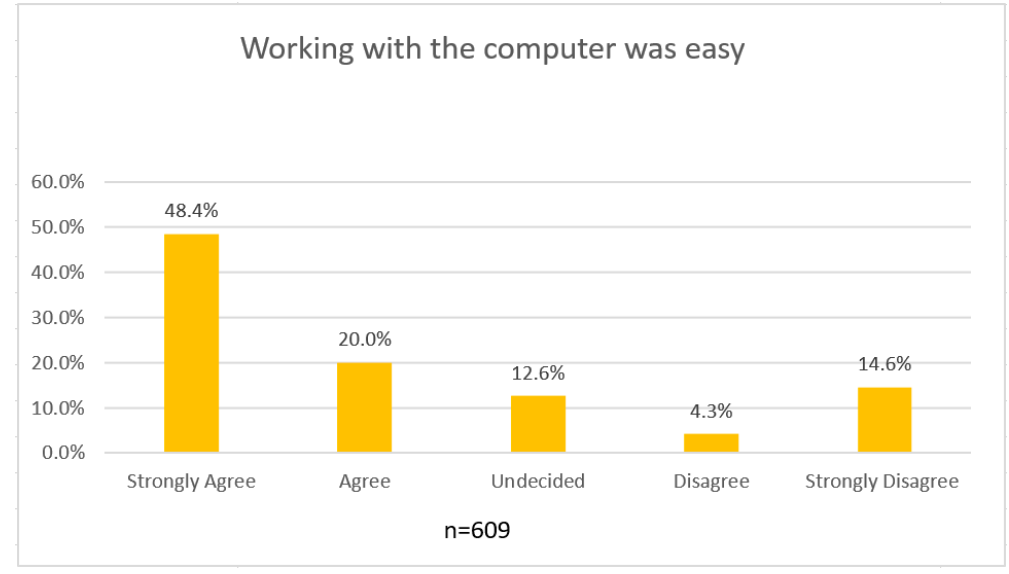
Figure 4. Pupils agreement with the statement: “Working with the compute was easy”.